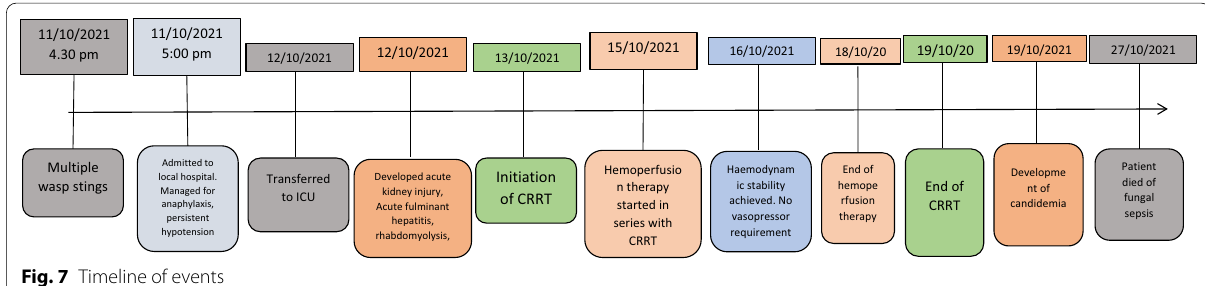
Fig. 7 Timeline of